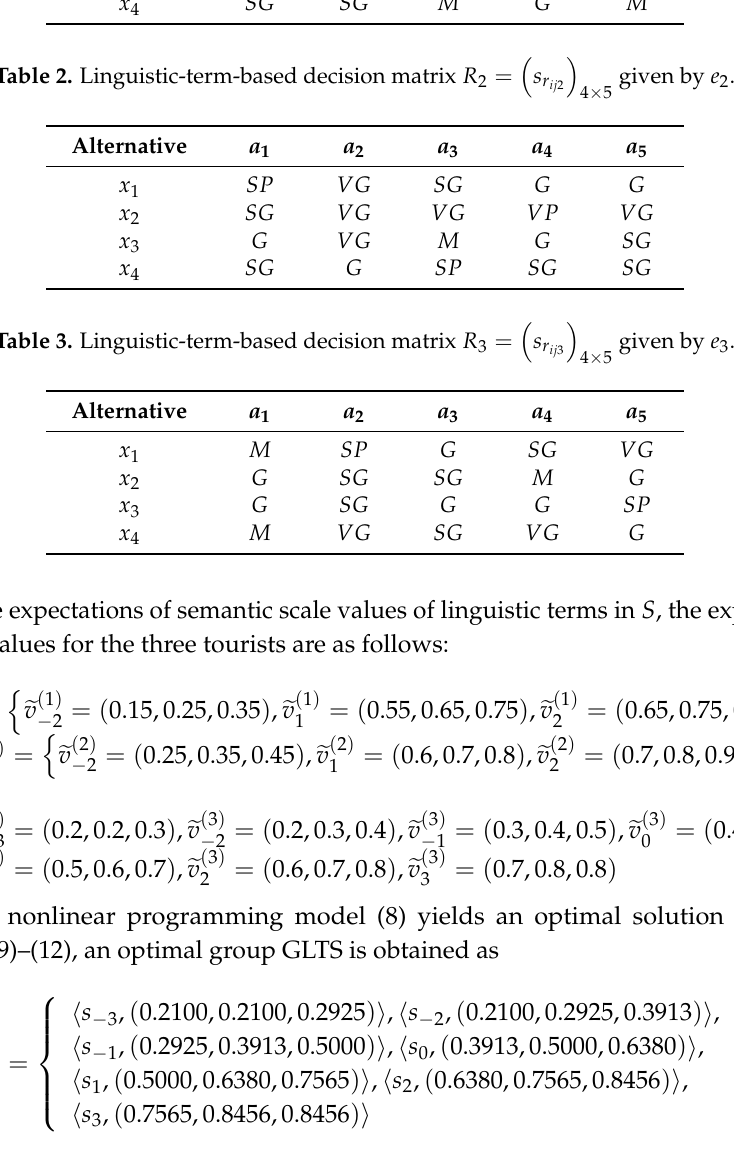
Table 2. Linguistic-term-based decision matrix R 2 =